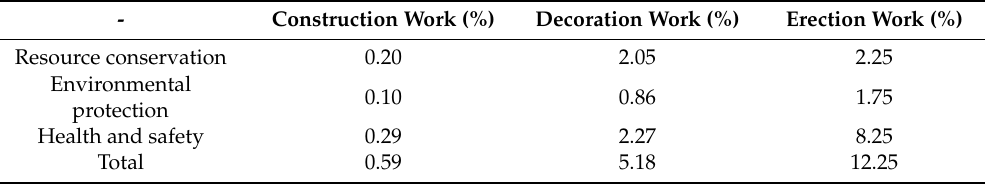
Table 1. Ratio of green construction measures cost to subengineering fees.